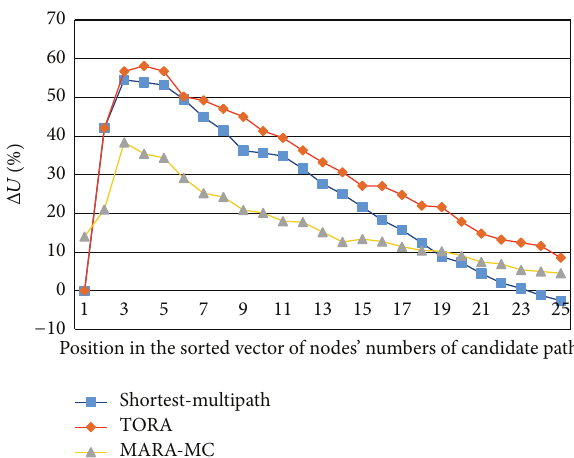
Figure 3: Relative comparison of the three algorithms for 50-node networks using the 𝑘 -shortest lexicographic solution as a reference: first 25 positions in the sorted solution vectors.